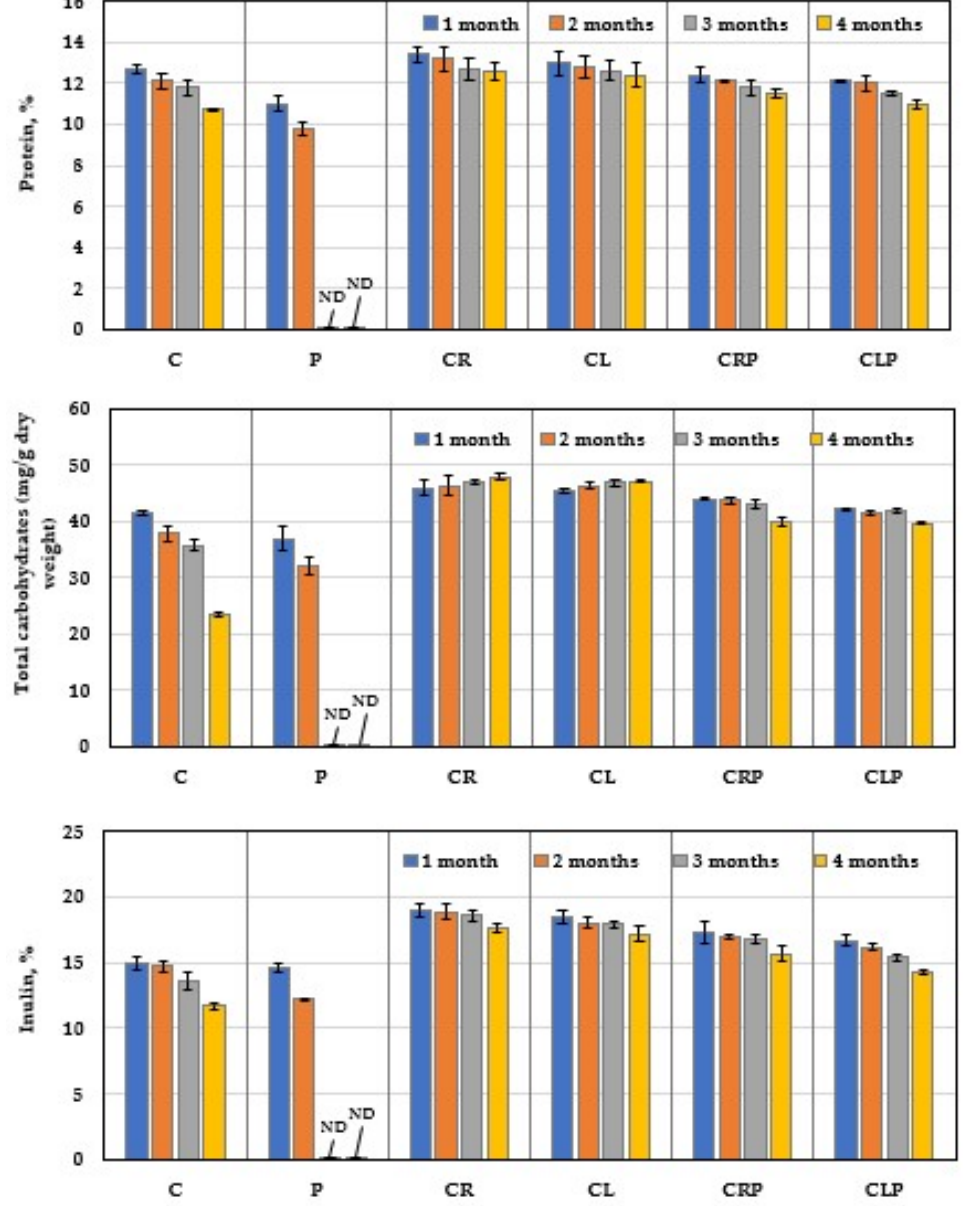
Figure 12. Comparative carbohydrates, inulin, and protein contents of JA tubers treated with caraway and clove essential oils and infected with P. polonicum under storage at 25 ± 2 °C (mean ± SD). C: untreated control; P: untreated infection by P. polonicum (ARS20); CR: treated with caraway oil; CL: treated with clove oil; CRP: treated with caraway oil plus infection by P. polonicum ; CLP: treated with clove oil plus infection by P. polonicum ; ND: not determined due to full